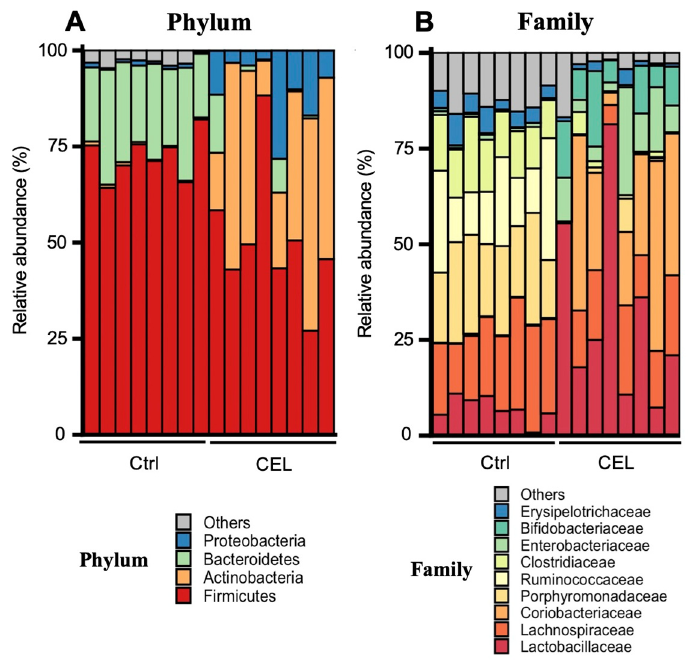
Figure 3. Effects of supplemental CEL on cecal microbiota composition at the phylum ( A ) and family ( B ) levels. Table 1. Effects of supplemental CEL on the relative abundance of genera in cecum of rats.